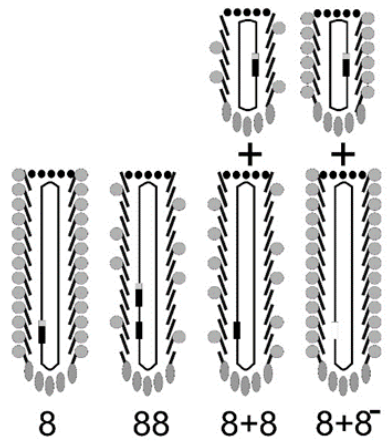
Figure 2. A type 8 vector (landscape-phage vector) contains multiple cloning sites in a single gene gpVIII . A type 88 vector harbors two genes: VIII , the wild-type gpVIII , and a recombinant rec- gpVII I that has the cloning sites. Type 88 phage capsids are composed of a mosaic of wild-type and recombinant pVIII proteins. In type 8 + 8 systems, the recombinant version and the wild-type version of gene VIII are on separate genomes: on a phagemid and on a helper phage ([11,27]). As for type 88 phage particles, the helper and phagemid virions in the type 8 + 8 system have a mosaic composition of recombinant and wild-type pVIII. In the type 8 + 8 − system, the helper phage lacks gpVIII , and all pVIII proteins are recombinant, as in the type 8 vector.